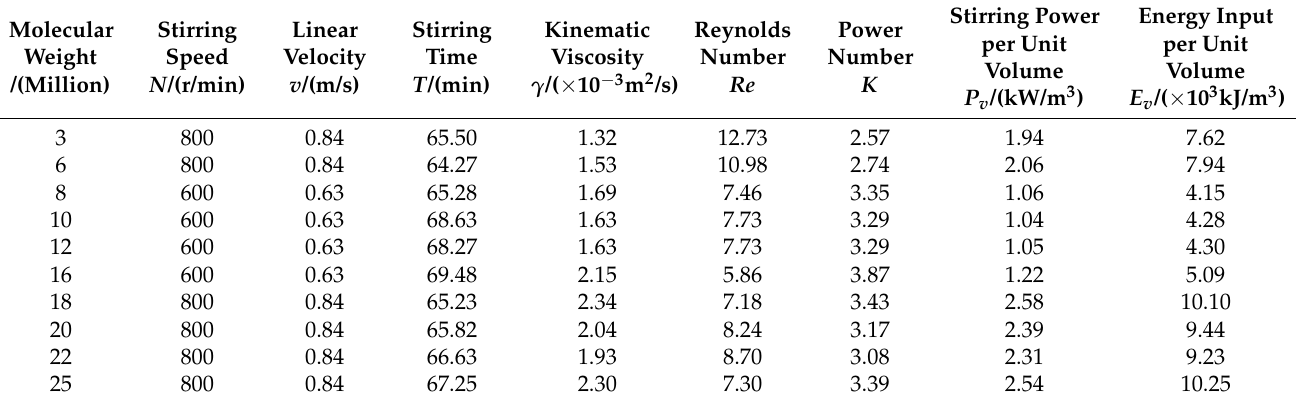
Table 1. Selection of stirring dissolution test results for APAM with different molecular weights.